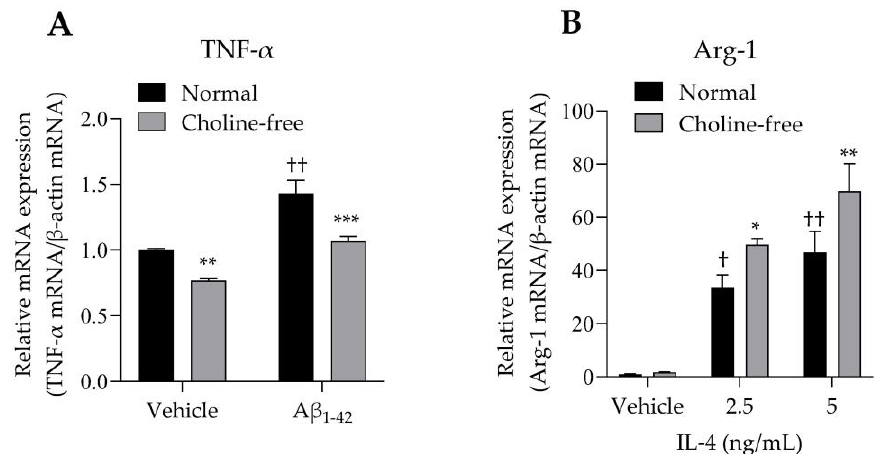
Figure 5. Effect of choline deficiency on TNF- α and Arg-1 mRNA expression in SIM-A9 cells stimulated by A β 1-42 and IL-4. ( A ) Expression of TNF- α mRNA in SIM-A9 cells stimulated with 10 µ M A β 1-42 in normal or choline-free medium for 4 h. Values are the mean ± SD ( n = 3). ** p < 0.005 and *** p < 0.0005 compared with normal culture medium under the same condition. †† p < 0.0001 compared with the vehicle of normal culture medium. Statistical analysis of the data was performed using Š í d á k’s multiple comparisons test. ( B ) Expression of Arg-1 mRNA in SIM-A9 cells stimulated with IL-4 (2.5 and 5 ng/mL) in normal or choline-free medium for 4 h. Values are the mean ± SD ( n = 3). * p < 0.05 and ** p < 0.005 compared with normal culture medium under the same condition. Statistical analysis of the data was performed using Š í d á k’s multiple comparisons test. † p < 0.01 and †† p < 0.0001 compared with the vehicle of normal culture medium. Statistical analysis of the data was performed using Dunnett’s multiple comparisons test. Relative expression is expressed as a ratio of the target mRNA to β -actin mRNA.